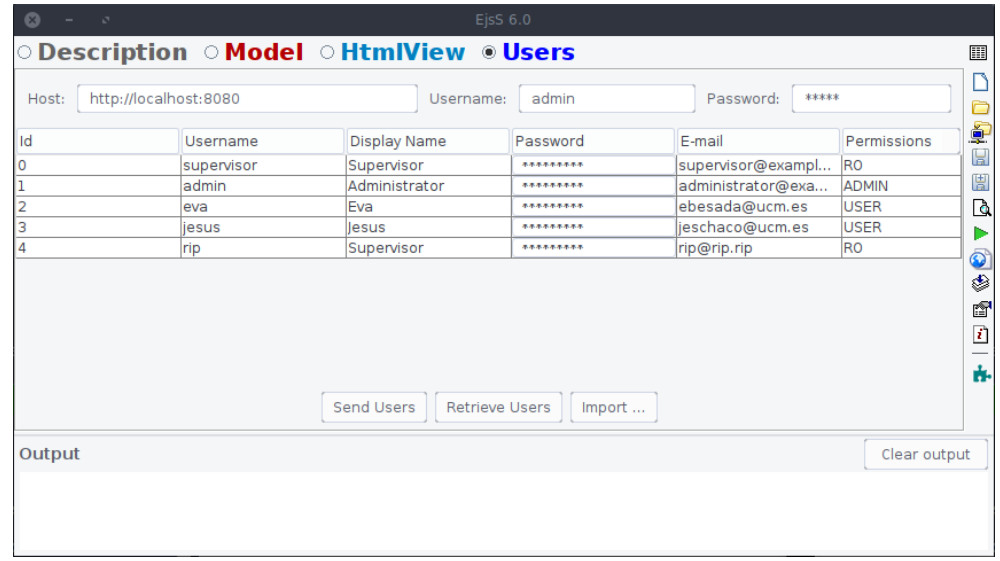
Figure 7. EJsS adapted with the Users Manager